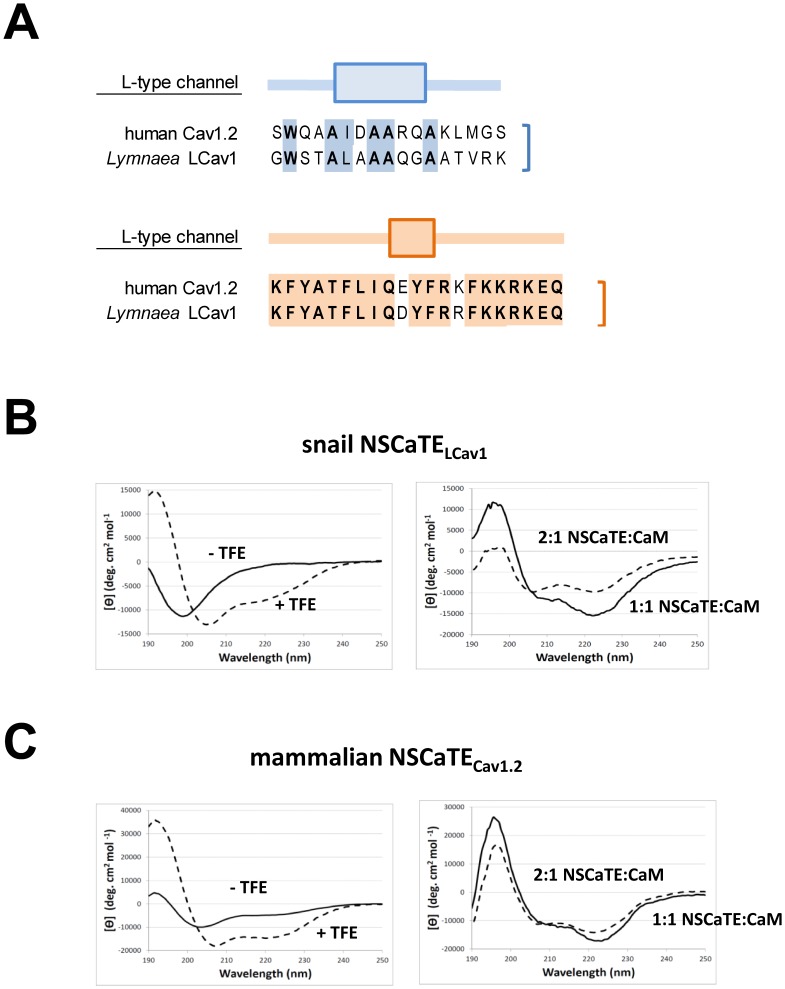
Snail NSCaTELCav1 and mammalian NSCaTECav1.2 peptides assume an alpha-helix upon binding calmodulin (CaM).(A) 17 mer NSCaTE and 21 mer IQ peptide sequences are used in circular dichroism (Figures 6) and Gel Shift Mobility Assays (Figures 7). (B,C) Differential spectra of NSCaTE peptide indicate a helical transformation with snail and mammalian NSCaTE upon addition of the helix stabilizing agent, trifluoroethanol (TFE: dashed line; no TFE: solid line, Figure 6B) or upon addition to CaM (solid line = 1∶1 CaM:peptide, dashed line = 1∶2 CaM:peptide, Figure 6C). Each trace is obtained by subtracting the 10 µM CaM-alone trace from the corresponding NSCaTE+CaM spectrum. Y axis units are mean residue ellipticity or (θ), (difference in spectra corrected for total protein/peptide concentration).